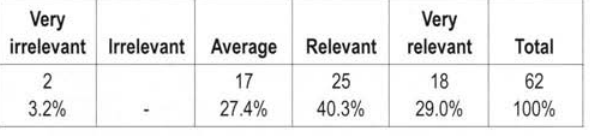
Table 11: Relevance of the subject offered in the present to the work situation At the PAl, 41 .7% each thought the subjects were